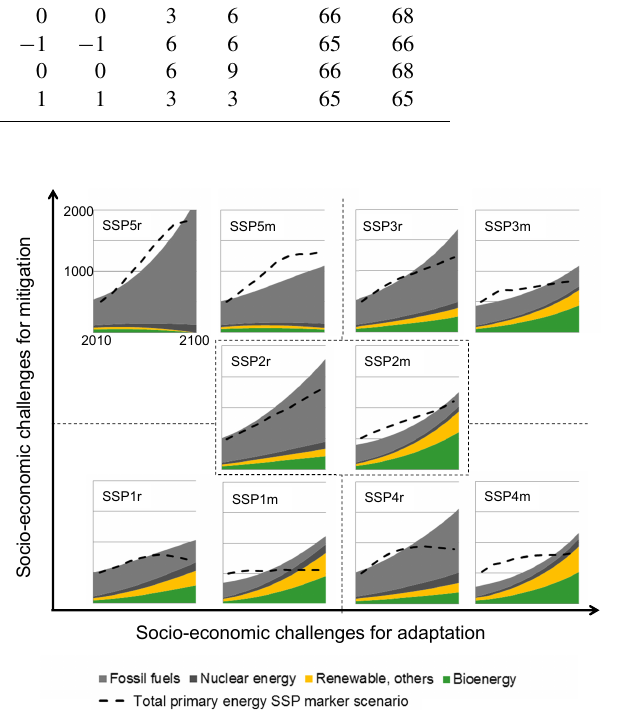
Figure 3. Primary energy demand (0–2000EJ; vertical axis of in- ternal panels) simulated by the climate–economy model for the ref- erence (r) and mitigation (m) versions of each SSP scenario (see Fig. 1) for the time period 2010–2100 (horizontal axis of internal panels). The dashed lines indicate the total primary energy of the of- ficial SSP realisations (SSP Database, 2015). The reference scenar- ios are compared with the baseline marker scenarios and the mitiga- tion scenarios are compared with the marker SSP1-RCP2.6, SPP2- RCP4.5, SSP3-RCP4.5, SSP4-RCP2.6 and SSP5-RCP6.0 scenario